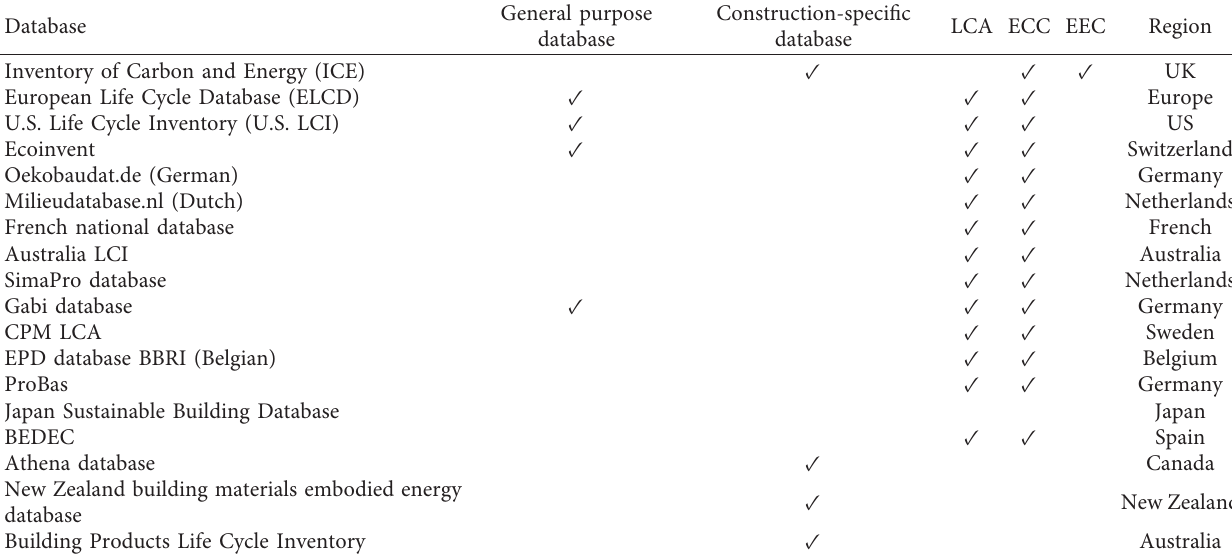
Table 2: Summary of sustainable